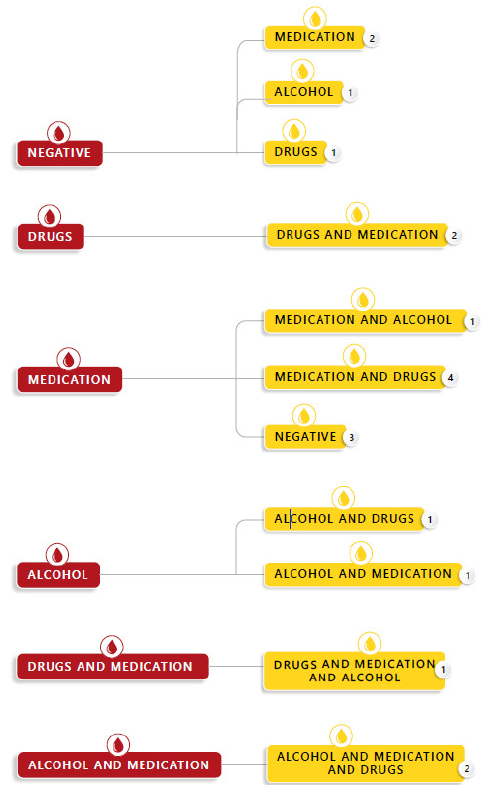
Figure 2. Discrepancies between compounds detected in blood and urine.